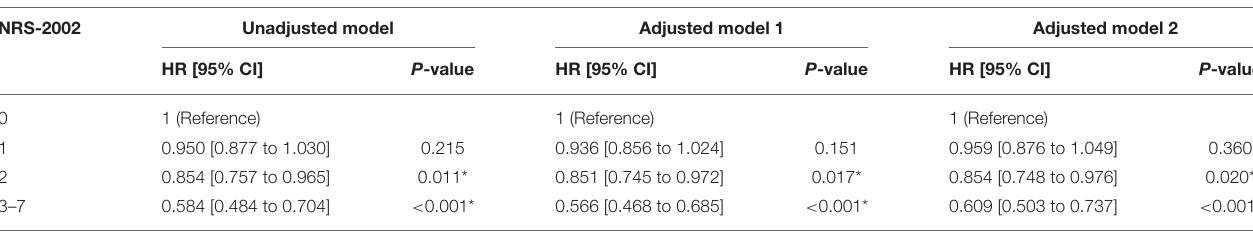
TABLE 3 | Cox regression analysis of NRS-2002 categories with time to